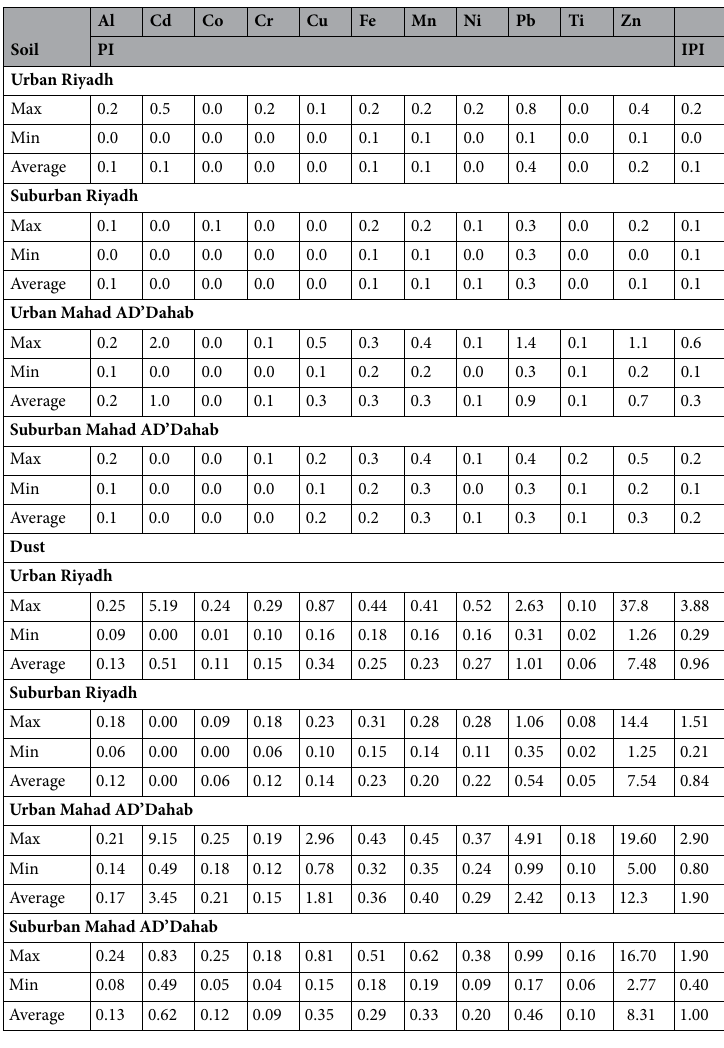
Table 3. The calculated data of the PI and IPI for heavy metals of soil and dust